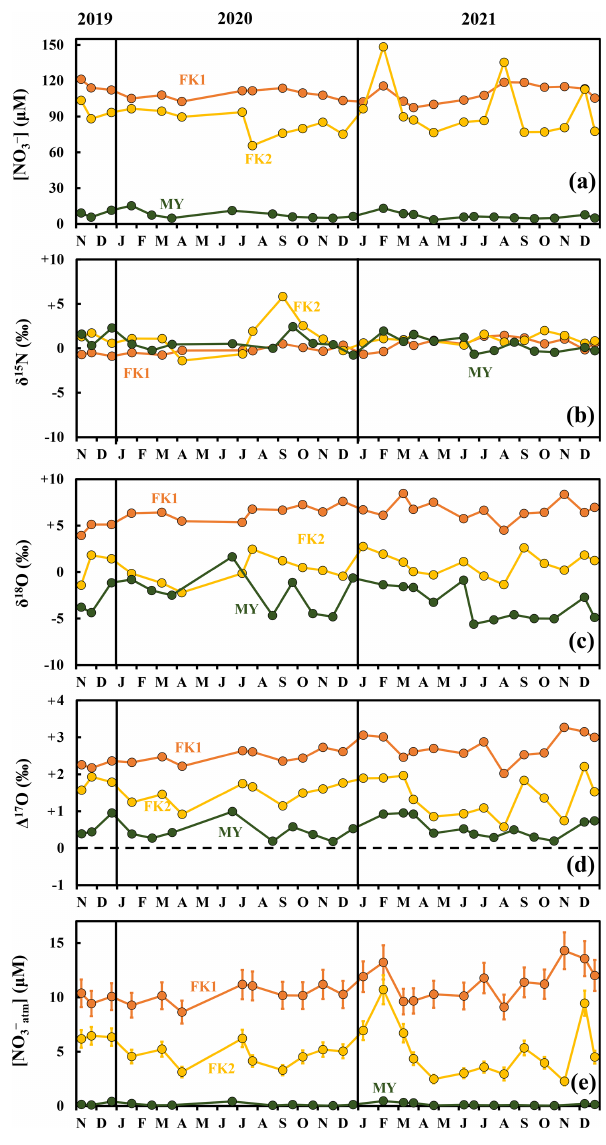
Figure 2. Temporal variations in concentrations of stream nitrate (FK1: orange circles; FK2: yellow circles; MY: green circles) (a) , together with those in δ 15 N (b) , δ 18 O (c) , and (cid:49) 17 O (d) of nitrate, and the concentration of unprocessed NO − the stream water of the FK1, FK2, and MY forested catchments. Error bars smaller than the sizes of the symbols are not